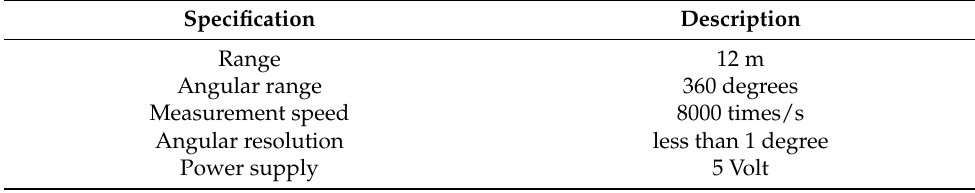
Figure 4. LiDAR. Table 4. Specifications of